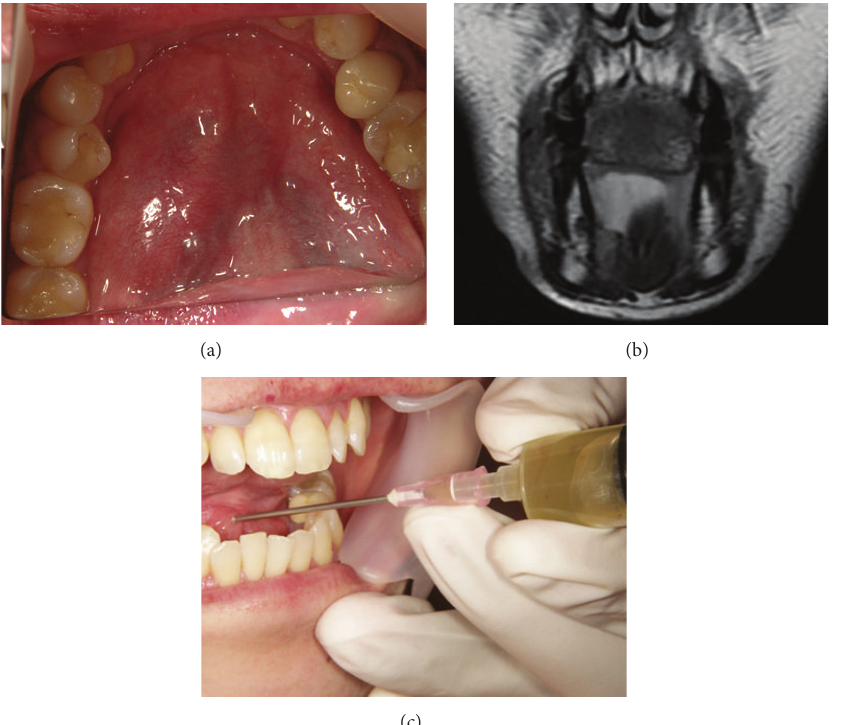
Figure 3: Appearance of the ranula at the first medical examination shows swelling of the anterior floor of the mouth (using mirror) (a). T2-weighted magnetic resonance images before treatment, showing the high-intensity areas in the right sublingual regions (b). The aspirated content from the cystic lesion was yellowish and mucinous